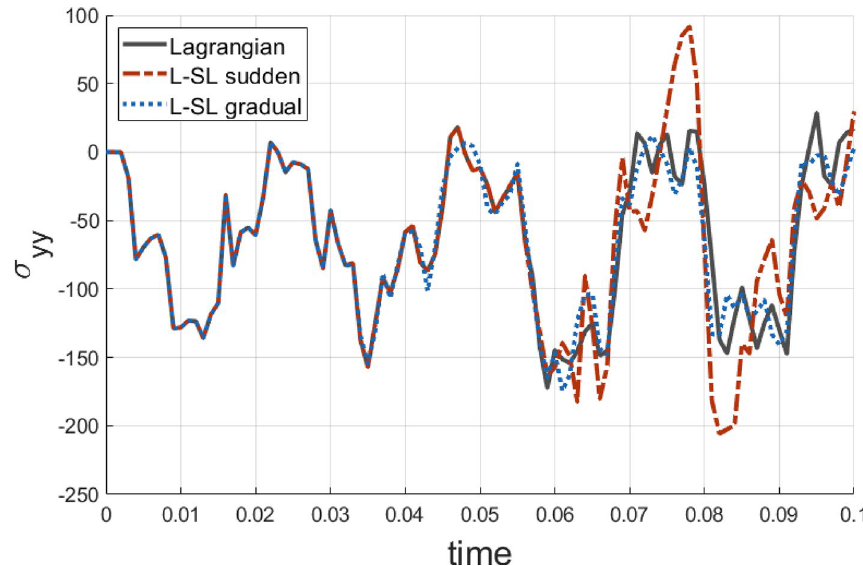
Fig. 11 Time history of the vertical stress at a depth of y = 5.0 m for pure L‑RK, sudden transition L–SL RK, and gradual transition L–SL RK cases; the sudden transition occurs at t = 0.05 s; the gradual transition occurs over 0.025 s < t < 0.05 s where the support sizes are linearly ramped over that period